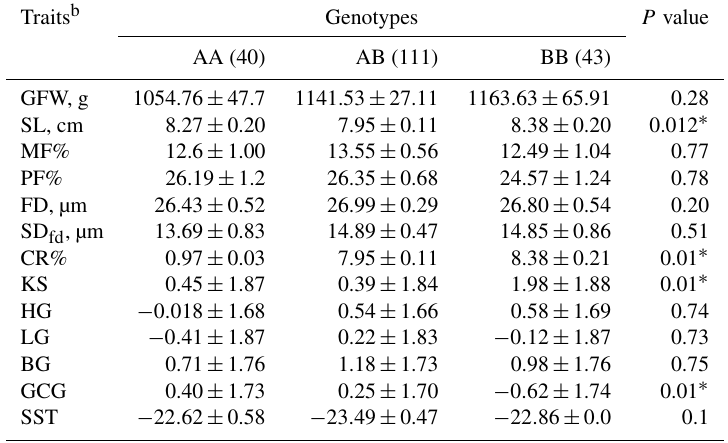
Table 5. Predicted least-square means and standard errors of the effect of KAP22-1 genotypes on the studied wool traits in Egyptian sheep a . Traits b